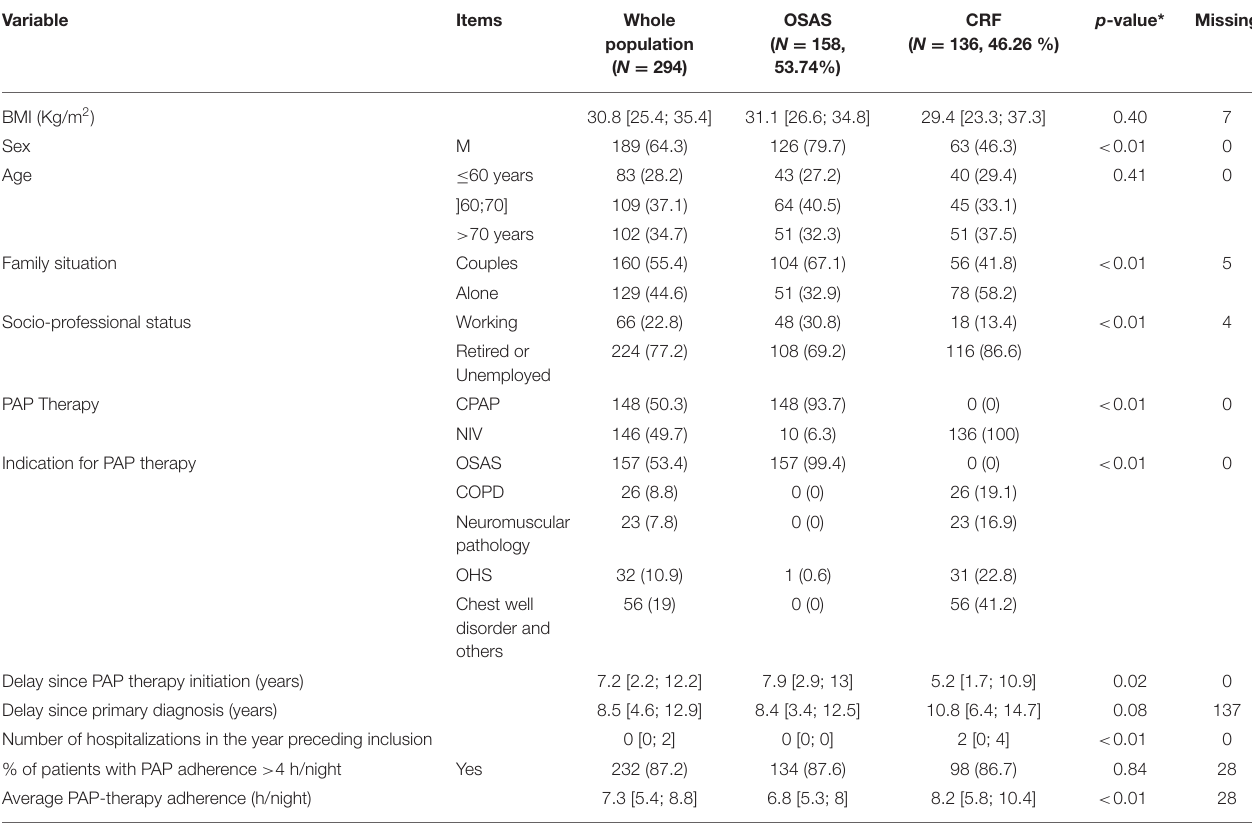
TABLE 1 | General and clinical characteristics of patients ( N = 294).